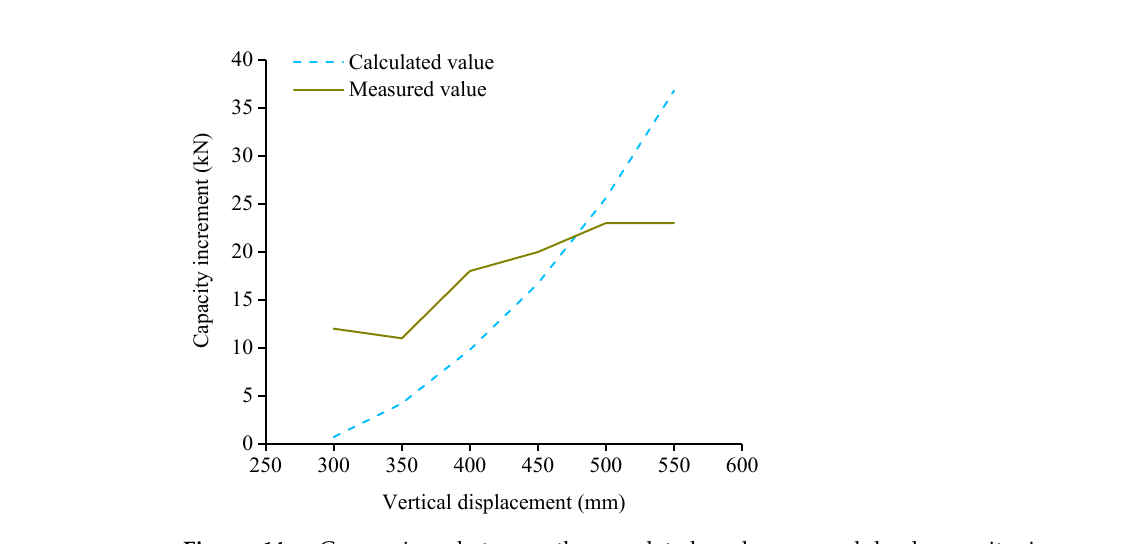
Figure 14. Comparison between the caculated and measured load capacity increment of specimen ICS.